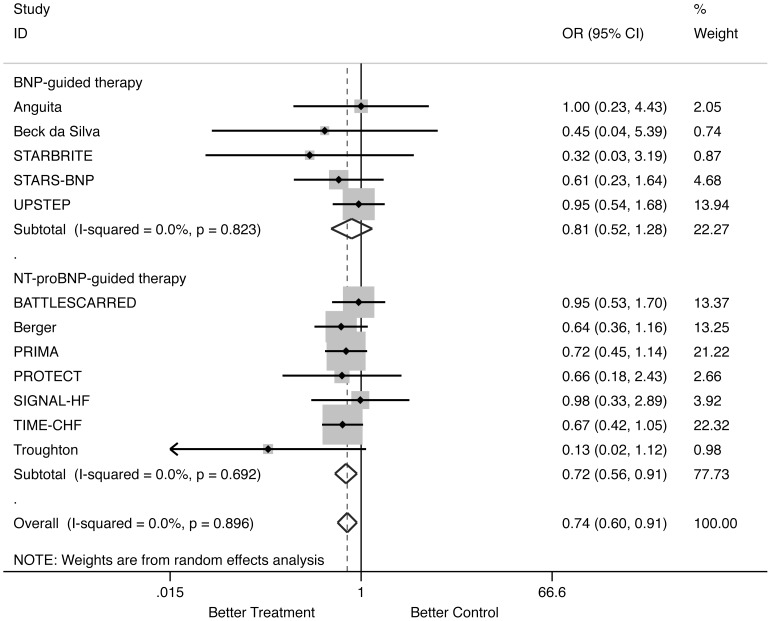
Odds ratios of all-cause mortality.Solid squares represent odds ratios in trials and have a size proportional to the number of events. The 95% confidence intervals for individual trials are denoted by lines and those for the pooled odd ratios by empty diamonds.